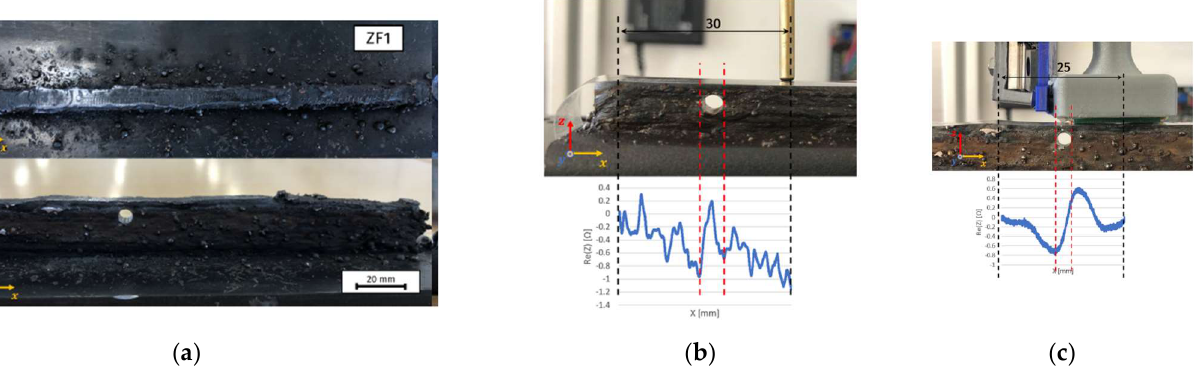
Figure 24. ECT inspection of hot-forging WAAM parts: ( a ) AISI 316L steel specimen with a 3 mm diameter hole defect, top and side view; ( b ) impedance output obtained at a frequency of 100 kHz with a commercial pencil probe; ( c ) impedance output obtained at a frequency of 100 kHz with an IOnic probe.